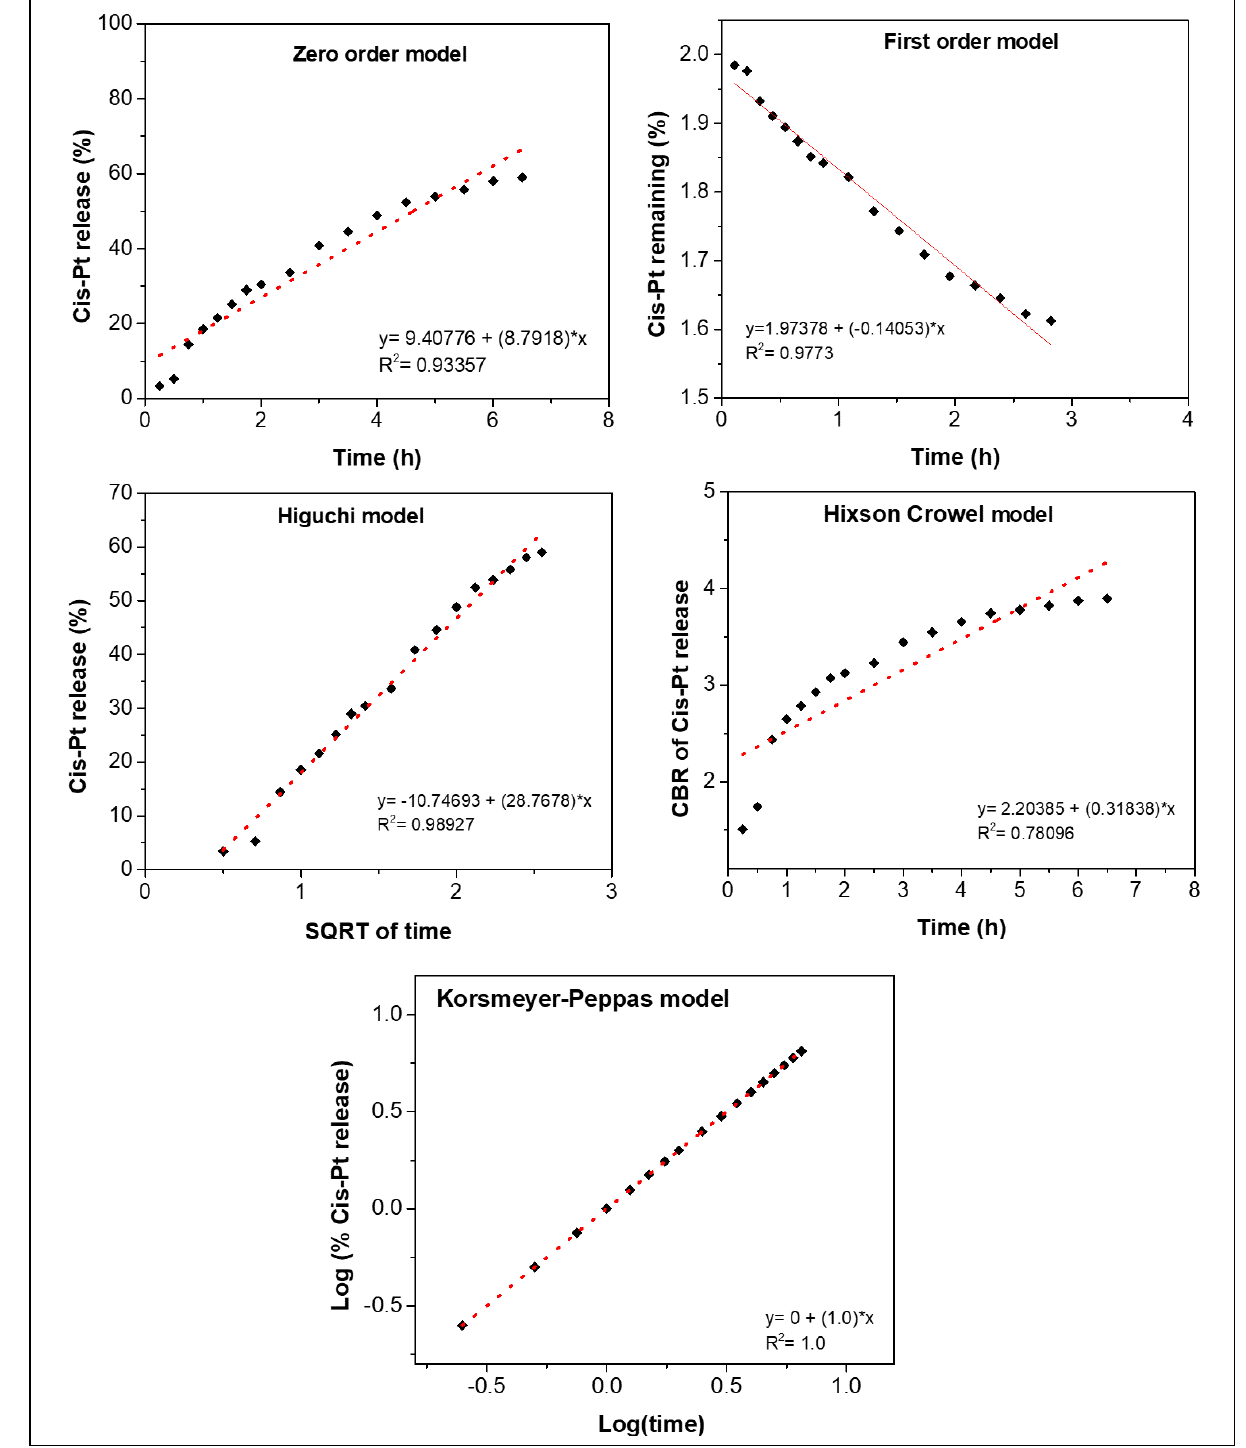
Figure 7: Mathematical Models fitted to experimental kinetic release of Cis-Pt. SQRT refers to square root, and CBR to cube